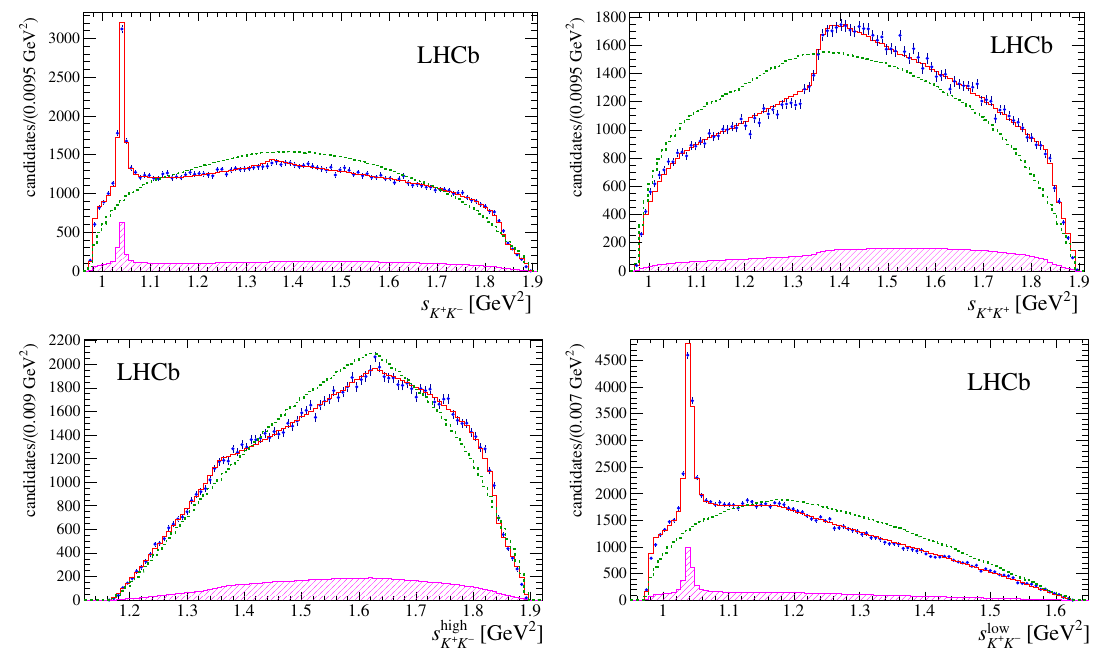
Figure 6 . Projections of the Dalitz plot onto (top left) s s high and (bottom right) s low K + K (cid:0)